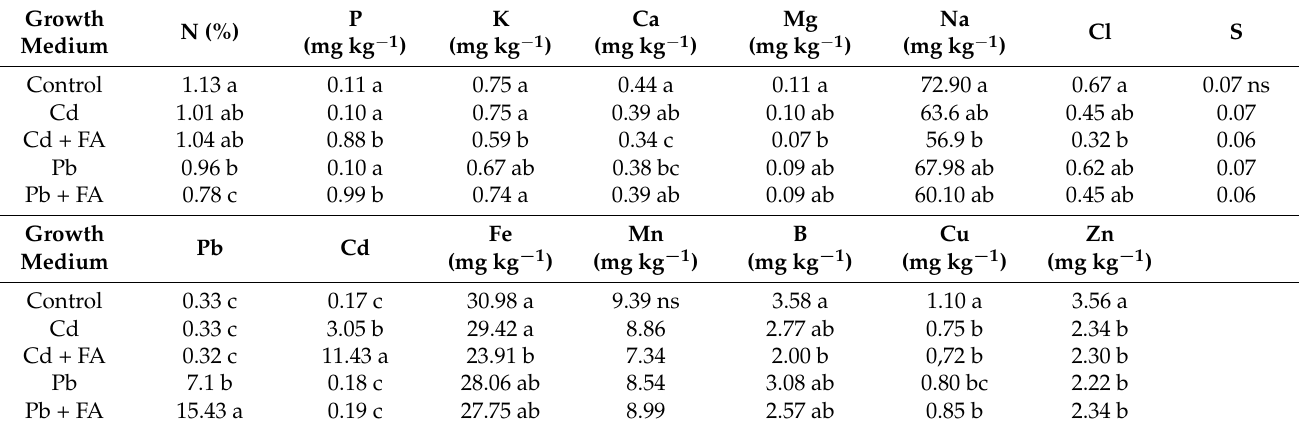
Table 6. The shoot part macro and micro element analysis results of Zinnia elegans